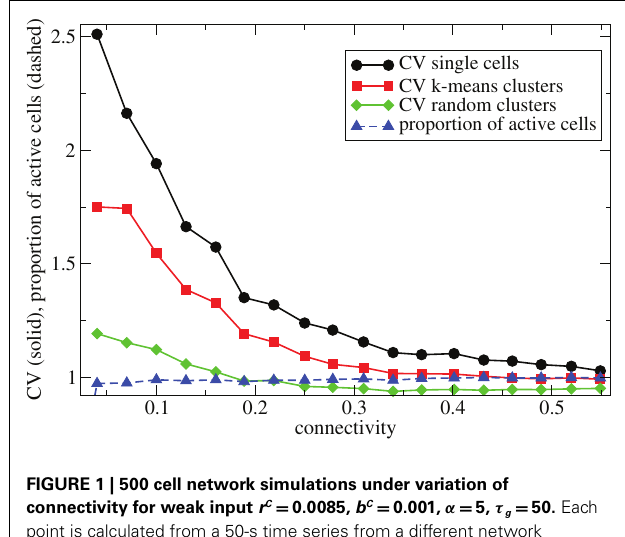
FIGURE 1 | 500 cell network simulations under variation of connectivity for weak input r C = 0.0085, b C = 0.001, α = 5, τ g = 50. Each point is calculated from a 50-s time series from a different network simulation. Black solid circles - mean CV over all cells. Red solid squares – mean CV of k-means generated clusters. Green solid diamonds – mean CV of randomly generated clusters. Blue dashed triangles - proportion of cells which fire at least one spike.